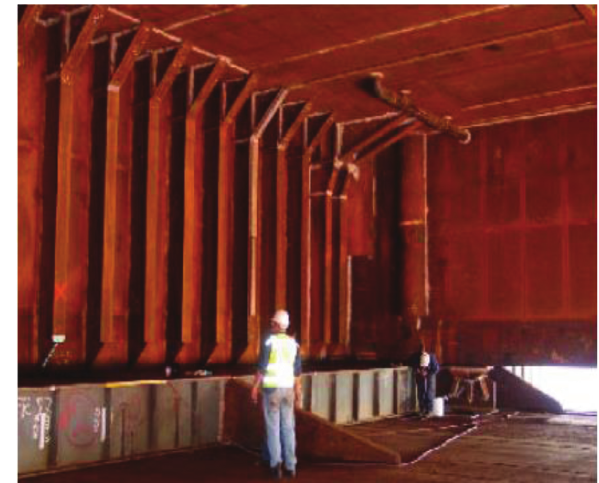
Figure 1: Photo of square stiffened caisson.